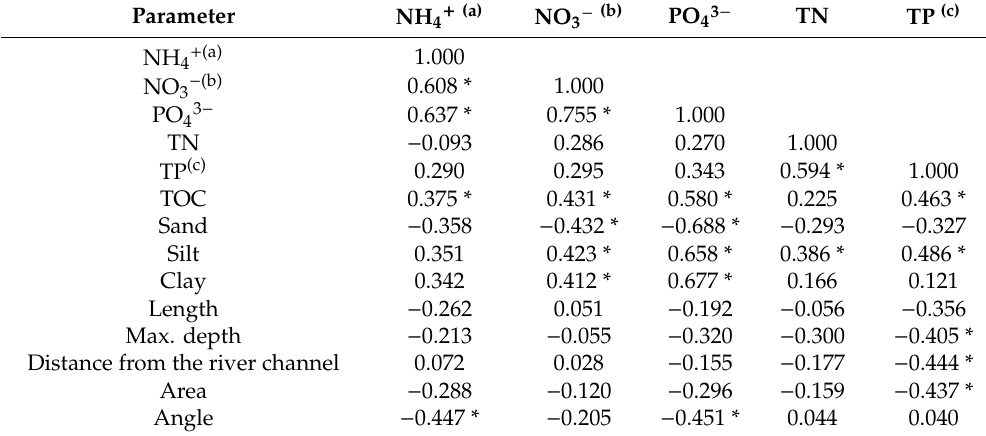
Table 2. Correlations of phosphorus and nitrogen compounds in sediments (the significance limit of